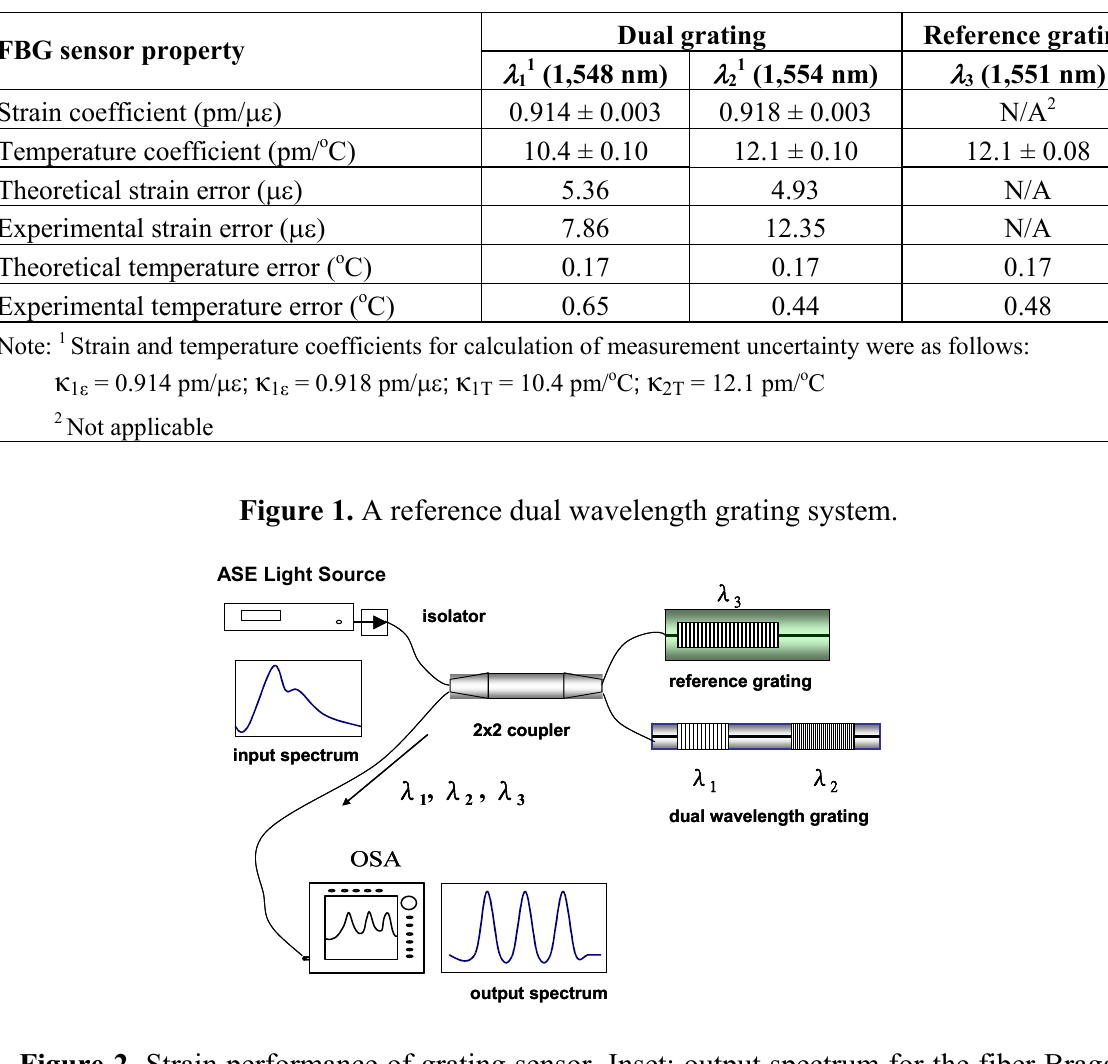
Figure 2. Strain performance of grating sensor. Inset: output spectrum for the fiber Bragg grating sensors with an applied strain at 0 με (black color) and 900 με (magenta color), respectively.